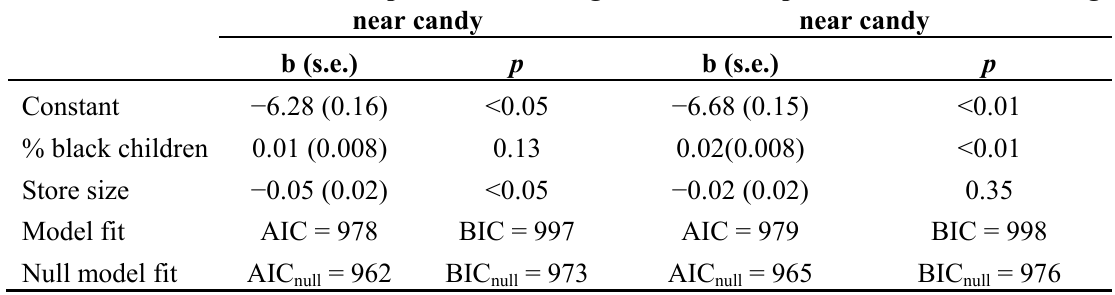
Table 4. The association between tobacco marketing at the point of sale and the proportion of black children in census